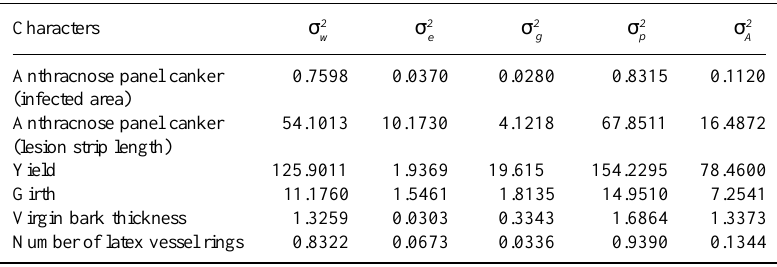
Table IV - Components of variance ( s 2 ) for six characters of 18 open-pollinated progenies of rubber tree ( Hevea brasiliensis